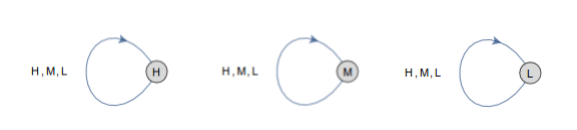
Figure 2: Unconditional strategies